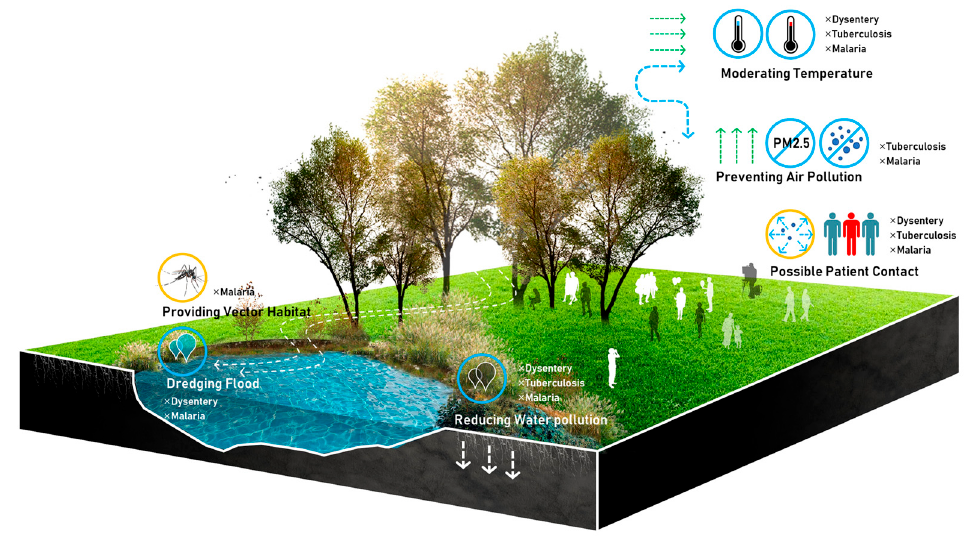
Figure 2. Dysentery, Tuberculosis, Malaria, and Green Space.